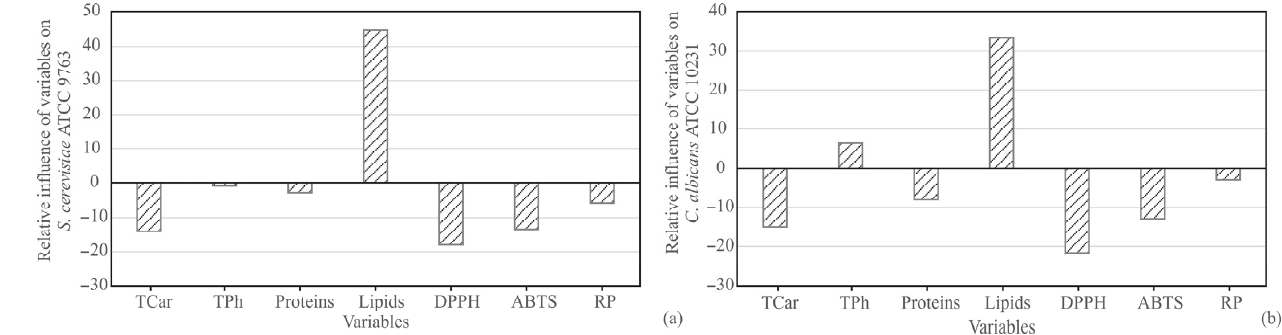
Figure 7. The relative importance of input variables on yeast strains in seed samples.